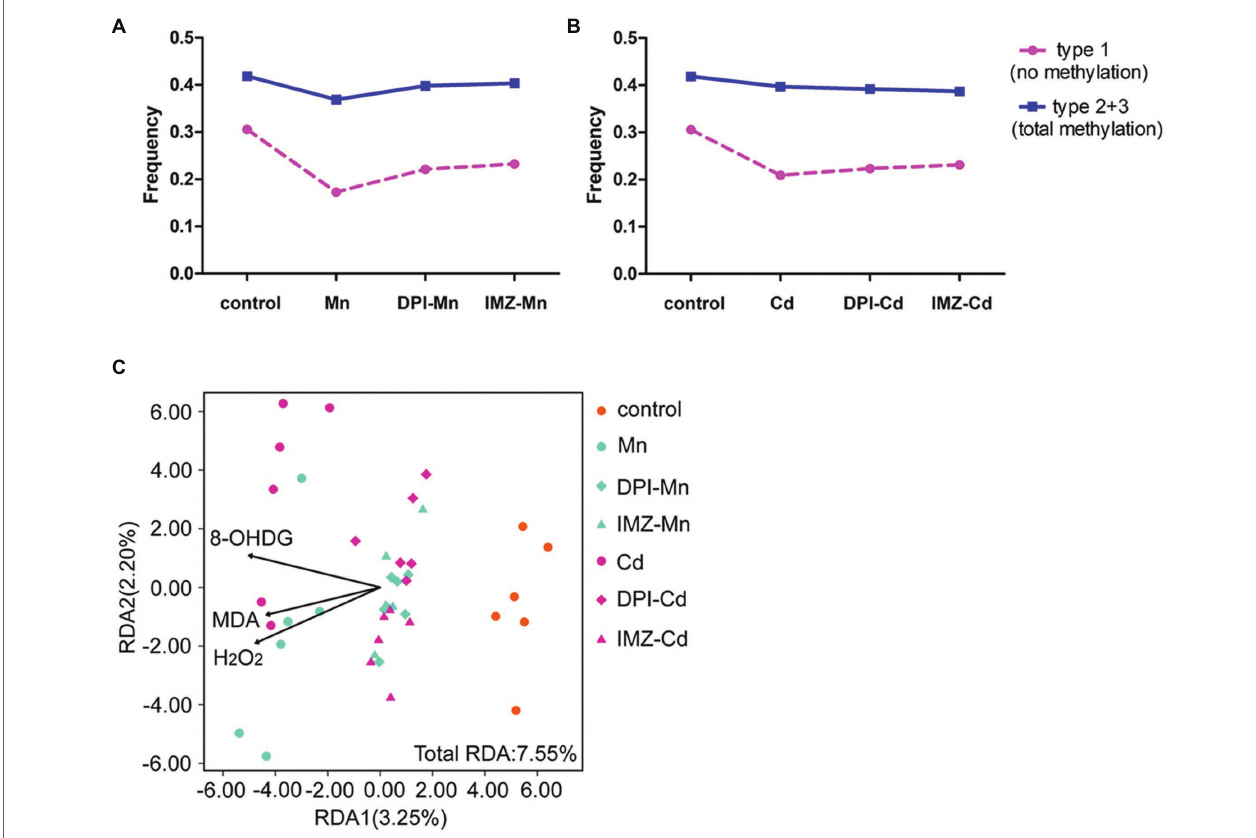
FIGURE 6 | The changes of DNA methylation variation based on MSAP profiling of pokeweed under excess Mn/Cd treatments or pretreated with NADPH oxidase inhibitors. (A,B) Frequencies of the four methylation types in seedlings exposed to (A) Mn treatments and (B) Cd treatments. DPI-Mn/Cd, IMZ-Mn/Cd, and Mn/Cd refer to samples pretreated with NADPH oxidase inhibitors (DPI and IMZ) or H 2 O prior to heavy metal exposure. (C) Redundancy analysis (RDA) to evaluate the relative importance of oxidative stress biomarkers (MDA, H 2 O 2 , and 8-OHdG) as explanatory variables of DNA methylation variation among